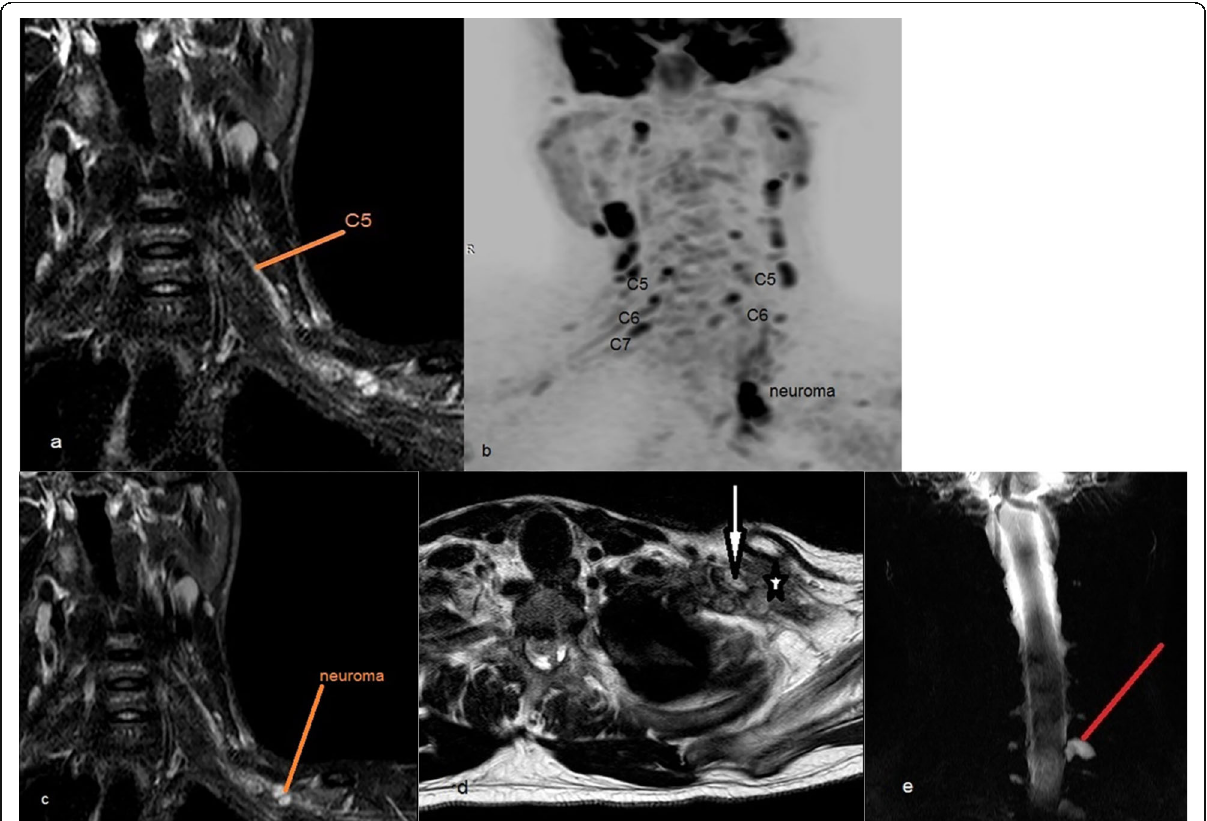
Fig. 1 A 24-year-old male patient presented with left traumatic brachial plexus injury following MBA 3 months before imaging. a MIP processing of coronal STIR shows high signal and thickened left C5 and focal thickening at the level of the left-sided cords. b MIP of coronal DWIBS shows thickened left C5 and C6 with restricted signal and traumatic neuroma. c Coronal STIR shows retracted avulsed nerves with a focal thickening at the level of the cords. d Axial T2WI shows focal thickening at the level of the cords (white arrow) and retracted nerves (*). e Radial myelography showing pseudomeningocele formation at T1 level. Intraoperative data are ruptured left-sided C5 and C6; avulsed C7, C8, and T1; and traumatic neuroma formation at the level of cords of the brachial plexus with adhesions around after operative repair of an injured subclavian artery immediately after the